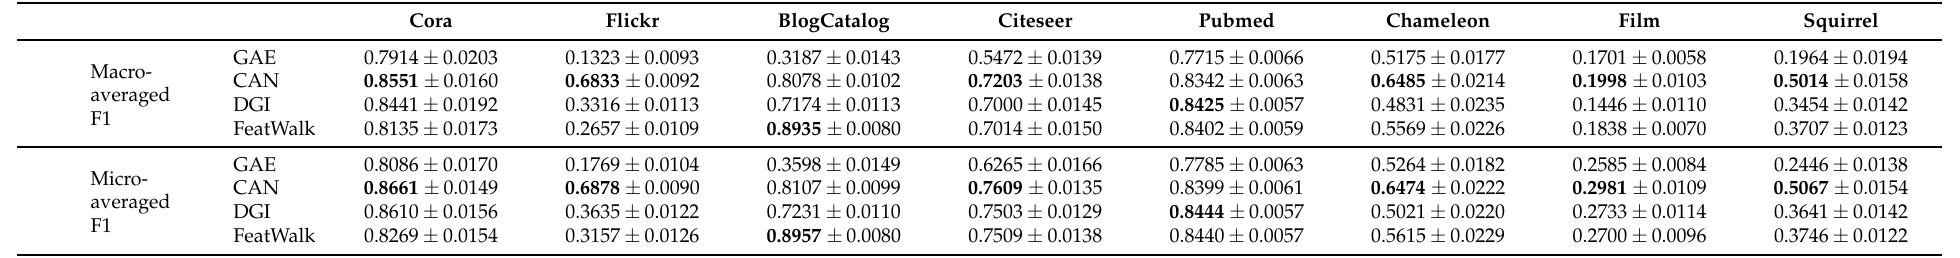
Table 8. Results in Task 3, i.e., classification fined-tuned via link prediction, on attributed networks, using random search to tune